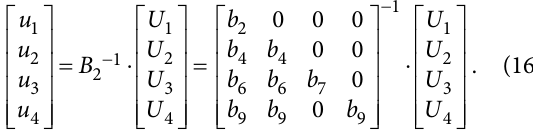
To prevent rear-wheel lockup in trajectory-tracking, for the CarSim ® brake system, the brake torque / wheel brake cylinder pressure values of the left and right front- wheels were set to y = 300 N ⋅ m/MPa, and the brake torque / wheel brake cylinder pressure values of the left and right rear-wheels were set to y = 150 N ⋅ m/MPa. The total control algorithm flow chart of the trajectory-track- ing controller (four channels) is shown in Figure 2. The general control rules of the controller are shown in Table spectively, while RF – Right Front and RR – Right Rear wheels, respectively.